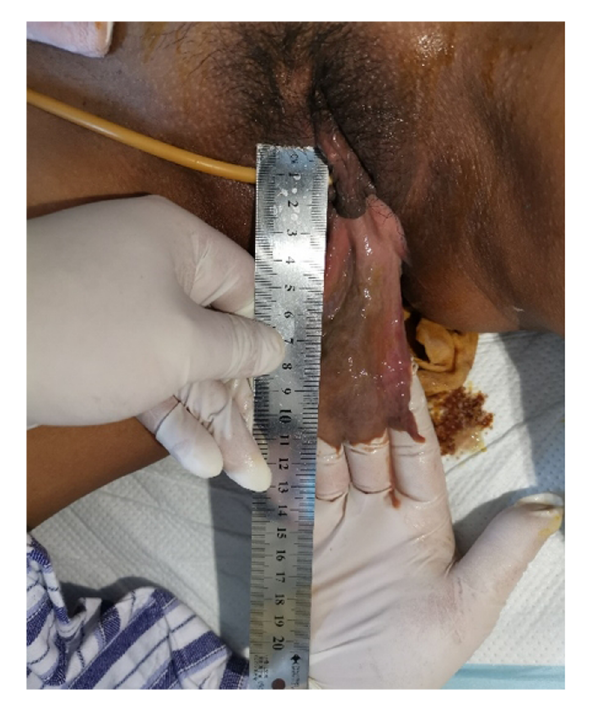
FIGURE 1 Prolapse day 1. A soft, hyperemia, edema, and bag-like excrescence was observed in the patient ’ s vulva, which could be self-repaired with a diameter of approximately 4 cm.